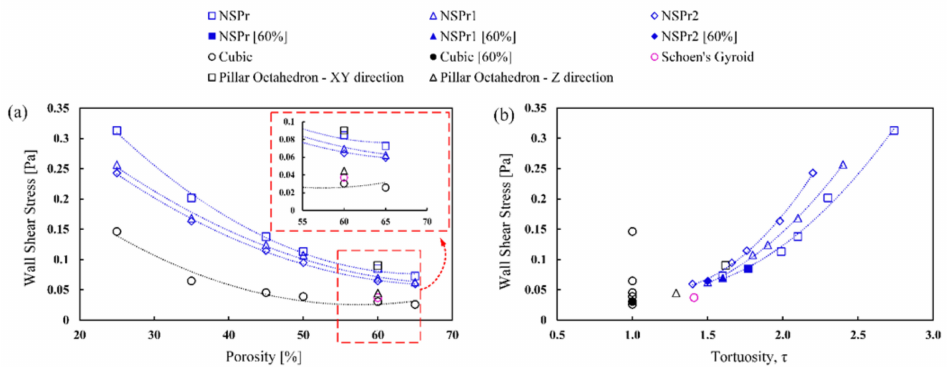
Figure 7. Relationship between WSS and: ( a ) porosity scaffold; ( b ) tortuosity